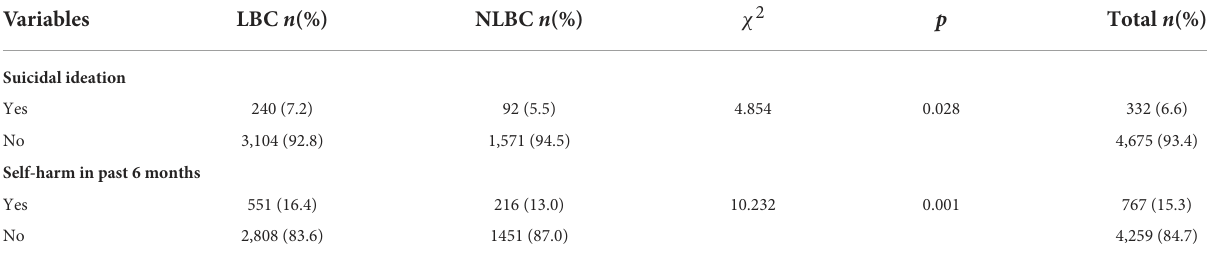
TABLE 2 Prevalence of self-harm and suicidality indicators in LBC ( n = 3344) and NLBC ( n = 1663) using Chi-Square Analysis.